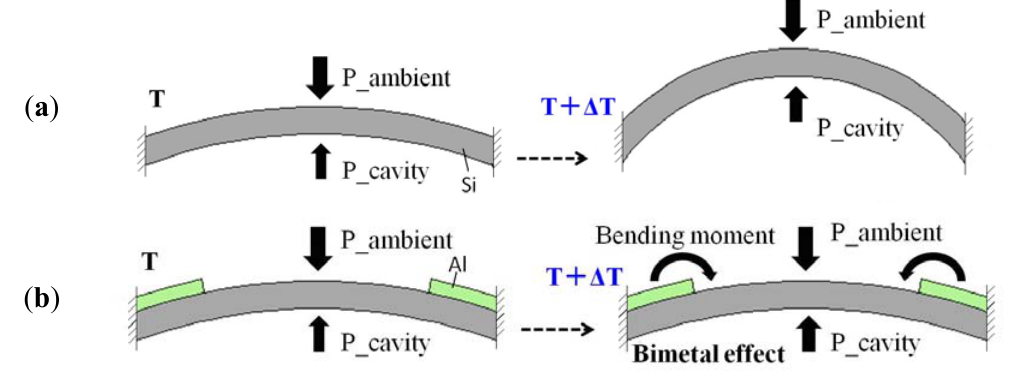
Figure 6. Temperature compensation mechanism. ( a ) diaphragm without compensation ring. ( b ) diaphragm with compensation